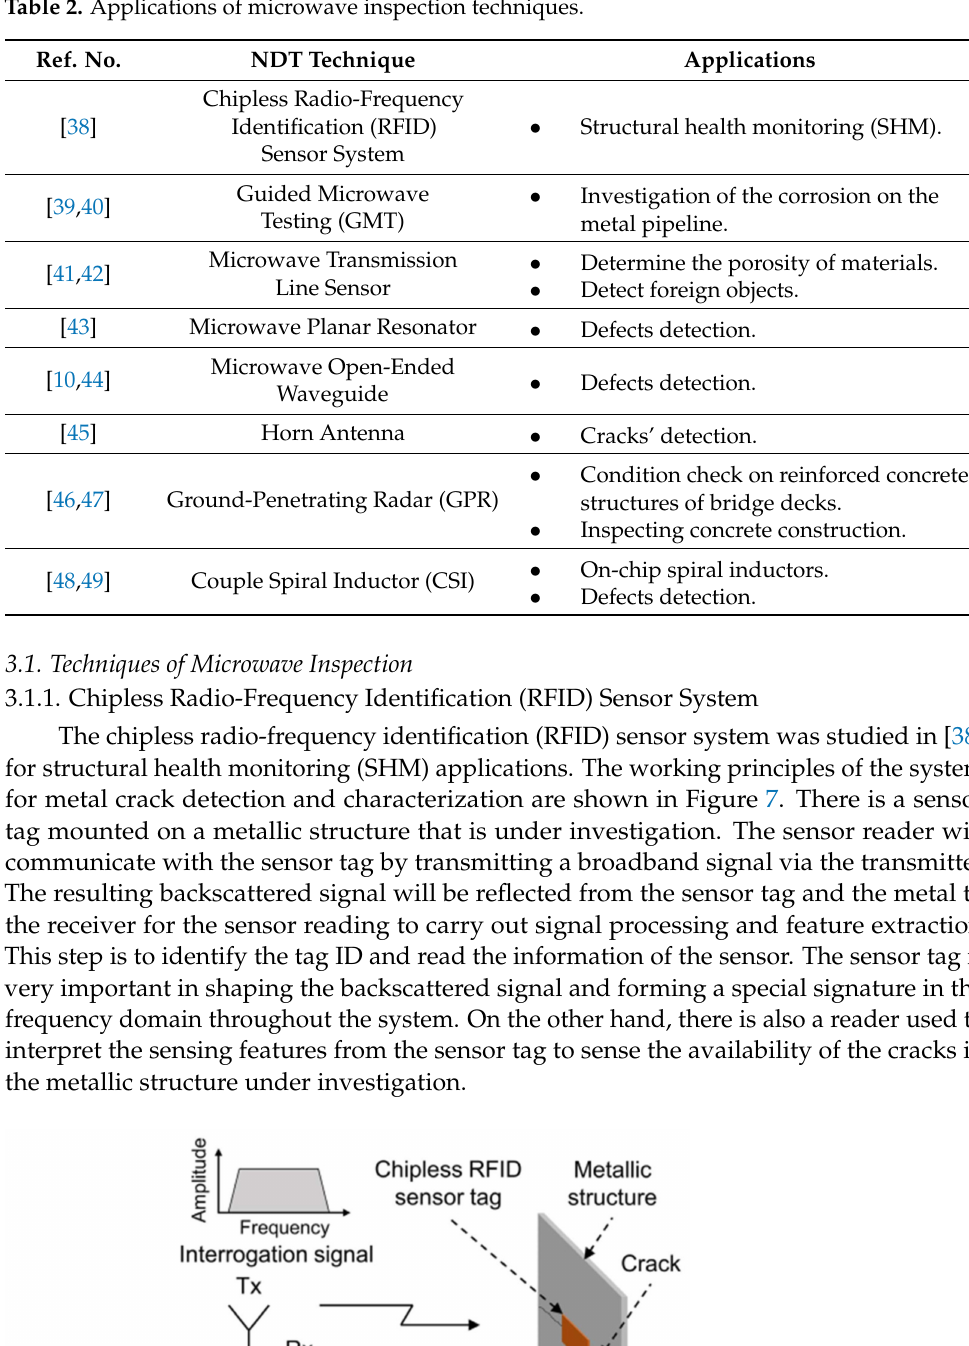
Table 2. Applications of microwave inspection techniques.